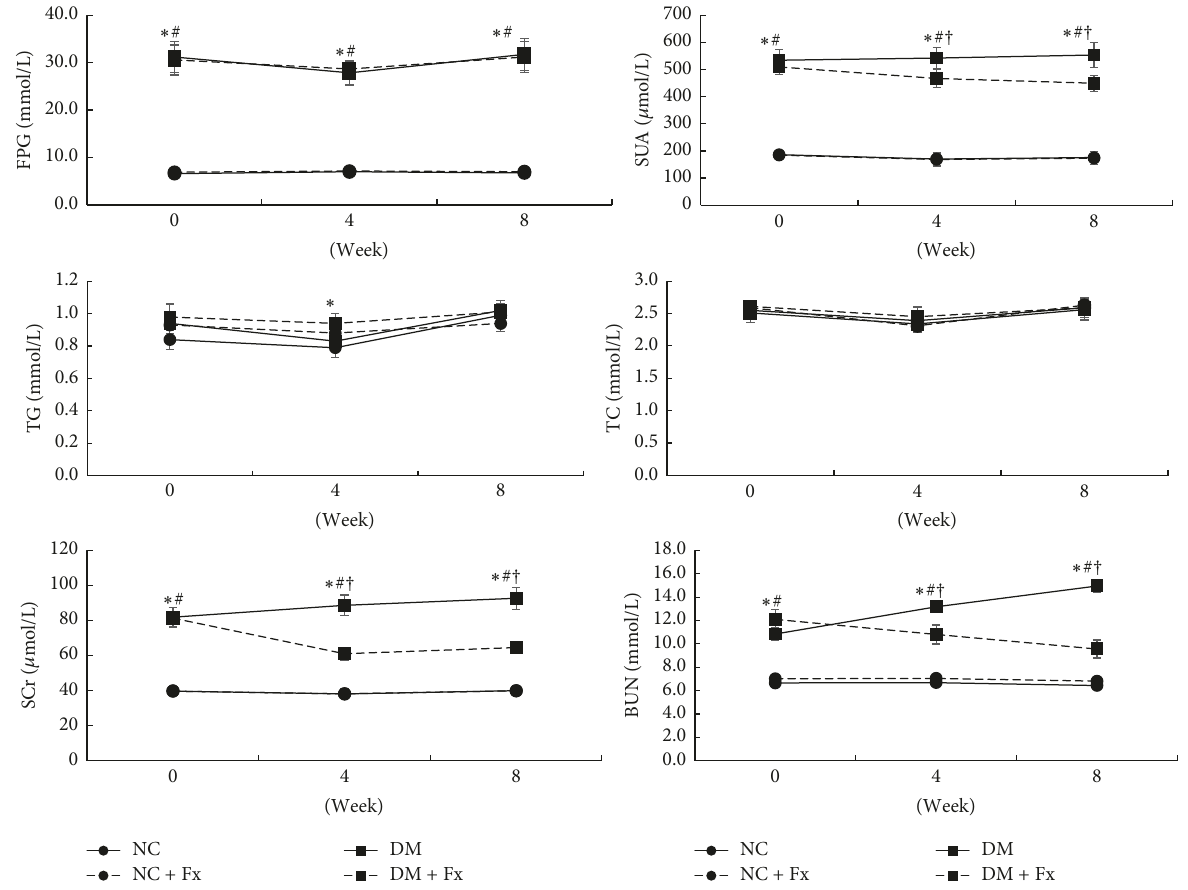
Figure 3: Time course of blood biochemical indices among the four rat groups. The circle with solid and dashed lines represents NC and NC + Fx groups, respectively, while the block symbol with solid and dashed lines shows data of DM and DM + Fx groups, respectively. Data are expressed as mean ± SD. Statistical significance ( 푃 < 0.05 ) was labeled as ∗ , #, and † correspondingly, when the DM + Fx group was compared with NC, NC + Fx, and DM